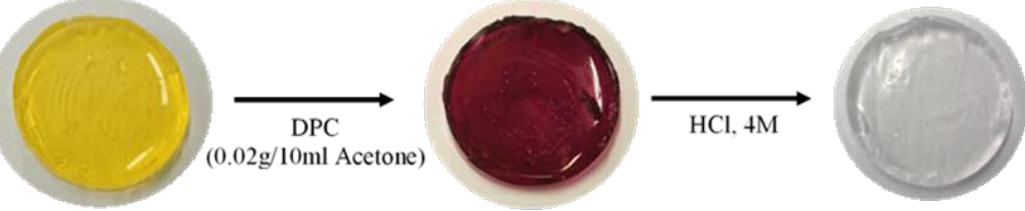
Figure 11. Regeneration method of silica-based xerogel.